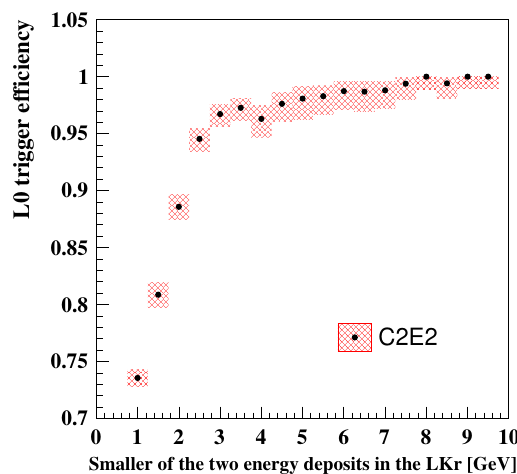
Figure 11. Efficiency of the C2E2 condition in beam-dump data, as a function of the smaller LKr energy deposit of the two tracks. The hatched areas indicate the statistical uncertainties of the measurements.